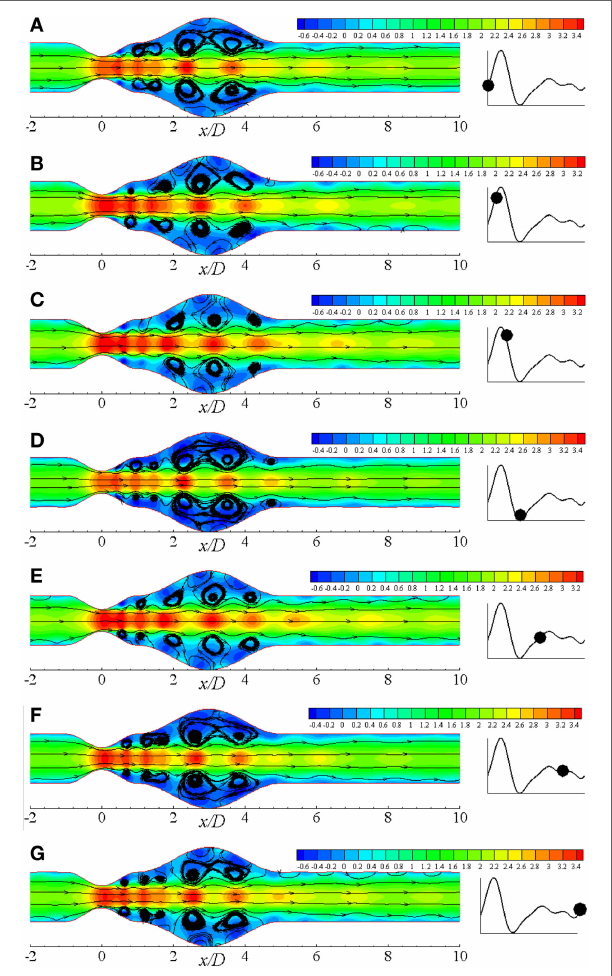
FIGURE 9 | Streamlines at different physiological phases (A) t / T = 9.0, (B) t / T = 9.1, (C) t / T = 9.2, (D) t / T = 9.3, (E) t / T = 9.5, (F) t / T = 9.7, (G) t / T = 9.10 when aneurysm = 100% dilated and stenosis = 60% constricted for Re = 500 where the amplitude of wall oscillation, A = 3 (cid:2) 10 (cid:0) 4